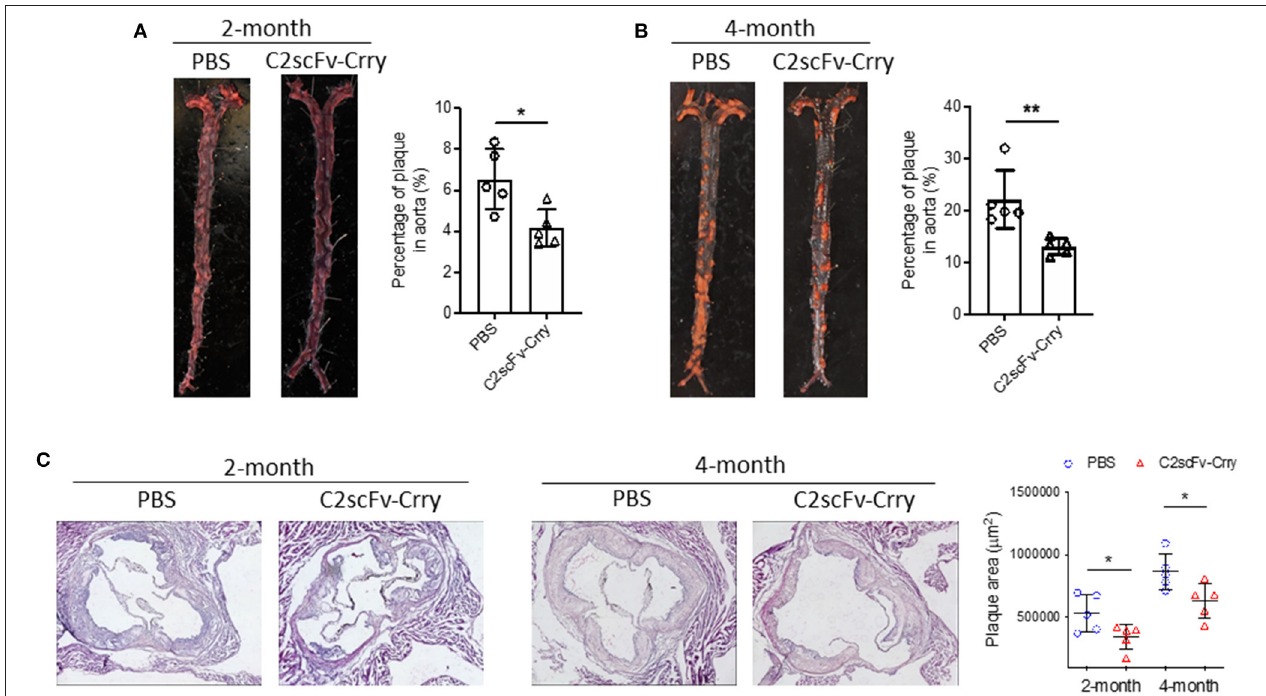
FIGURE 2 | C2scFv-Crry attenuates atherosclerosis plaque in Apoe − / − mice fed with high-fat diet (HFD) for 2 or 4 months. Apoe − / − mice were fed a high-fat diet (HFD) and treated with PBS or C2scFv-Crry (0.25 mg/mice, twice a week) for 2 or 4 months, followed by quantification of atherosclerosis plaque. (A,B) Representative images (left) and quantification (right) of aortic en face plaque area determined by Oil Red O (ORO) staining for 2-month (A) and 4-month groups (B) . Quantification represents the percentage of ORO-stained plaque areas in the entire aorta. (C) H&E staining of cross-sections of aortic root in Apoe − / − mice treated with PBS or C2scFv-Crry. Left: representative images. Right: quantification plaque aera in aortic root (* p < 0.05, ** p < 0.01 using unpaired Student’s t